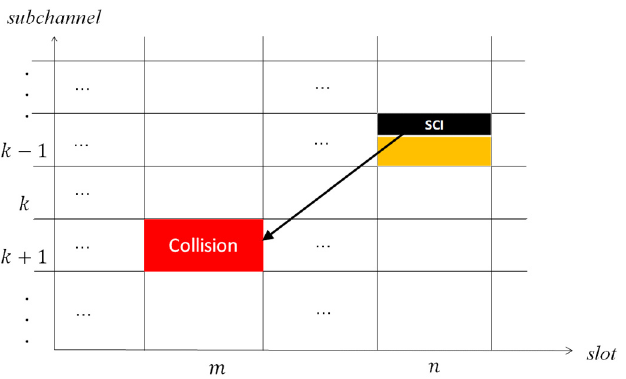
Figure 6. Feedback information in SCI pointing to the resource location of the suspected packet collision.